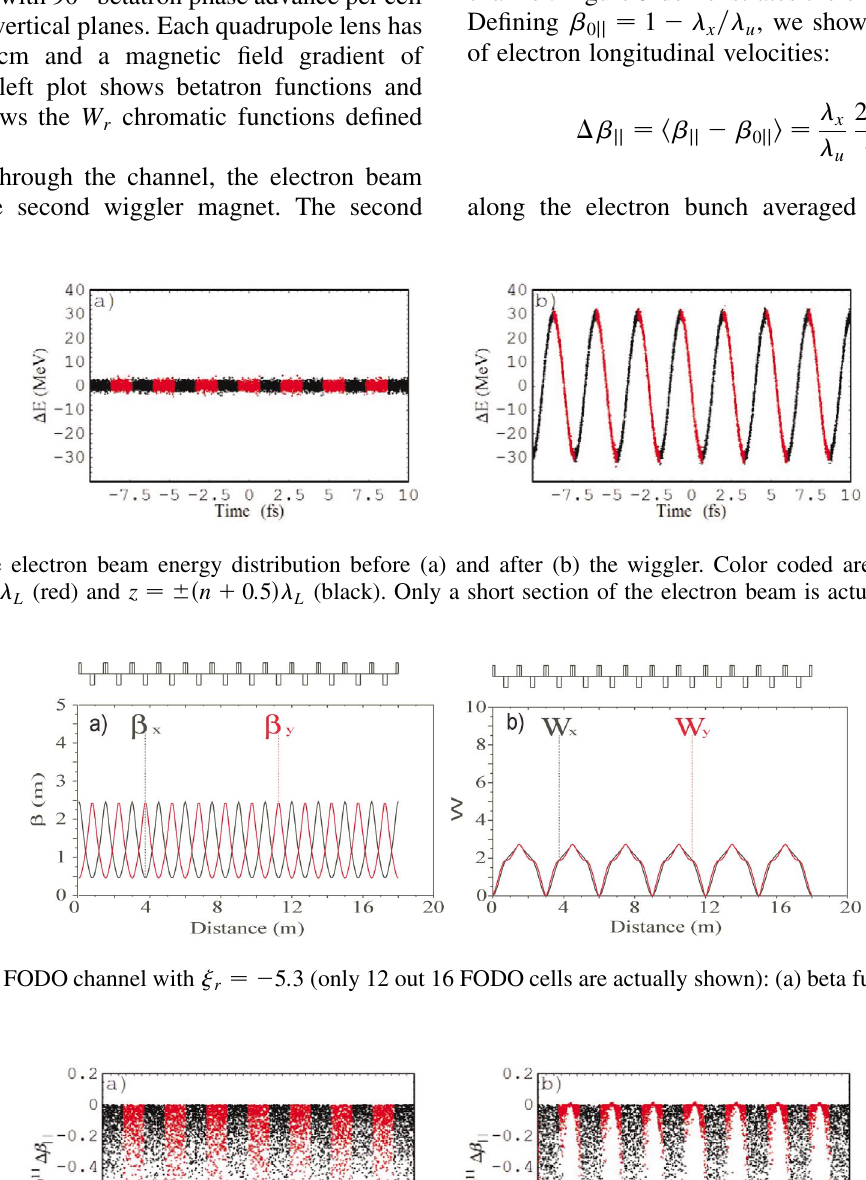
FIG. 5. (Color) A distribution of the electron longitudinal velocities for unconditioned (a) and conditioned (b) electron beams. An uncorrelated energy spread is ignored. Color coded sections within the electron beam are the same as in Fig.